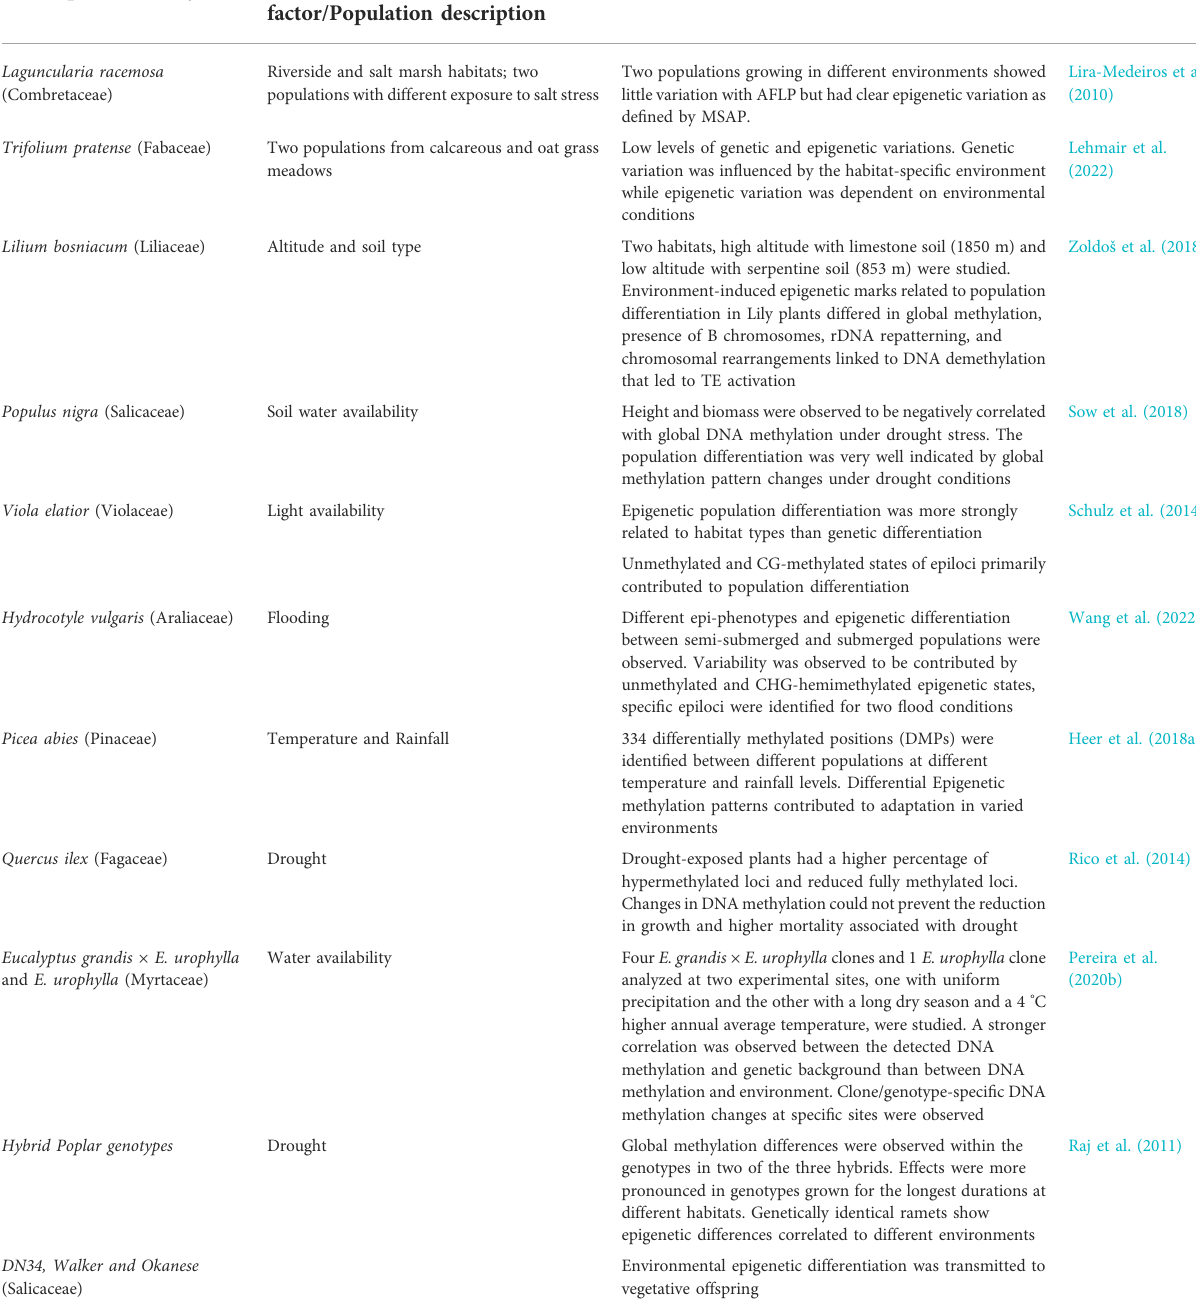
TABLE 2 The instances of epigenetic diversity and its relationship with environmental